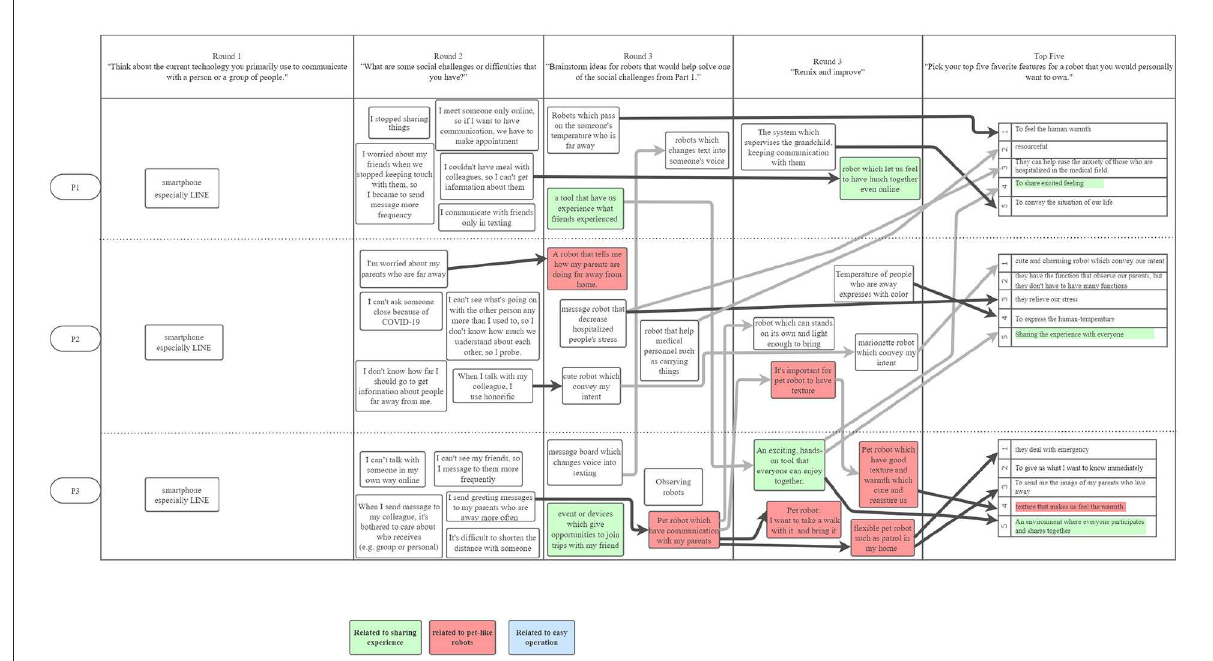
FIGURE5 The first PD session in Japan was held on August 29, 2021 and had 3 participants. Dark black arrows indicate concepts that were carried forward in development. Two of the top themes were heavily discussed among the participants: sharing experiences and pet-like robots. All three participants chose a feature related to sharing experiences in their “top 5”.